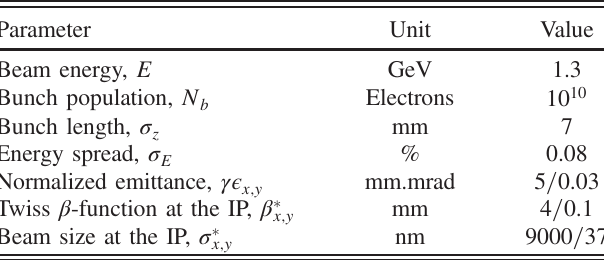
TABLE I. ATF2 nominal beam parameters.